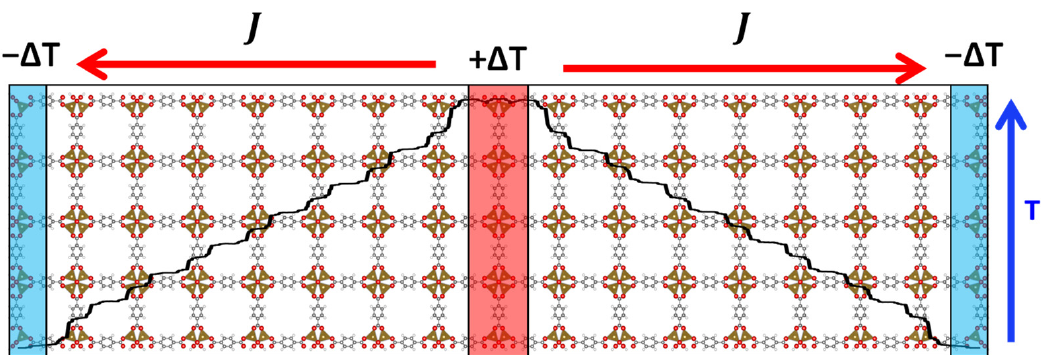
Figure 2. Schematic representation of a non-equilibrium molecular dynamics (NEMD) simulation (employing periodic boundary conditions). Two regions of the simulation box are connected to two thermostats at temperatures T ± ∆ T , where T is the temperature at which the thermal conductivity is calculated. A heat flux J emerges from the hot to the cold thermostat. There is a discernable fine structure in the temperature profile with terraces at the positions of the nodes and linkers and steps at their interface.